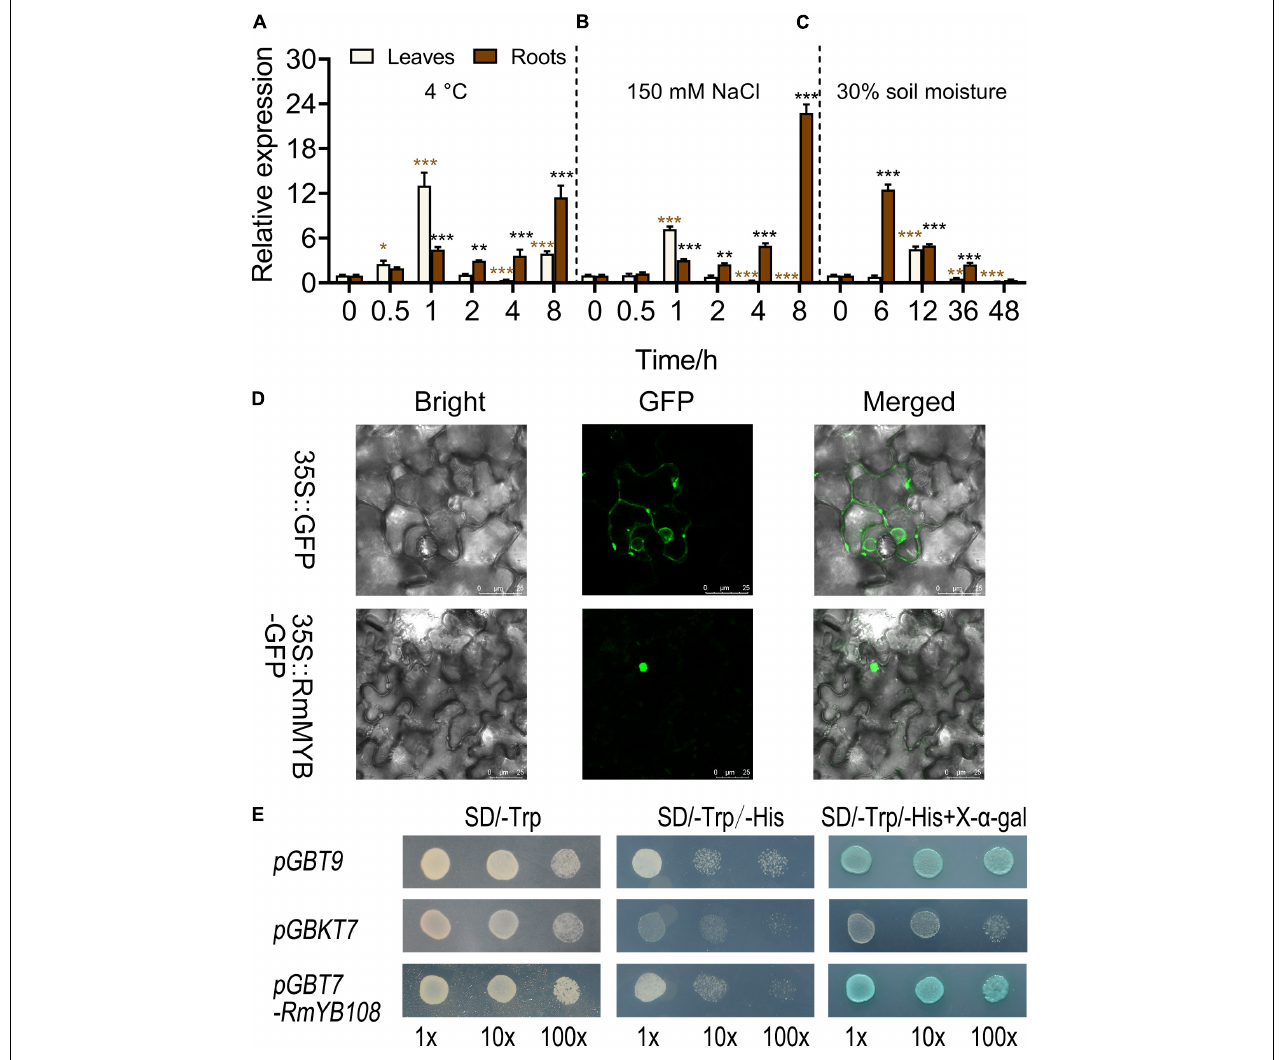
FIGURE 3 | Analysis of gene expression, localization, and transactivation assay of the RmMYB108 transcription factor. RmMYB108 expression patterns in R. multiflora leaves and roots responding abiotic stress under continuous 4 ◦ C (A) , 150 mM NaCl (B) , and drought (C) treatment. (D) The positive control 35S::GFP and 35S::RmMYB108 constructs were expressed in tobacco epidermal cells, showing the nuclear localization of RmMYB108 . (E) Transcriptional activation assay of RmMYB108 . Growth of yeast cells (strain AH109) transformed with pGBT9 vector (a positive control), pGBKT7 vector (a negative control), or pGBKT7- RmMYB108 vector on SD/-Trp or SD/-Trp/-His with or without X- α -gal. 10 × , 10 × , and 100 × represent yeasts were diluted with original concentration (OD600 = 0.4), 10–, 100-folds, respectively. * p < 0.05; ** p < 0.01; *** p < 0.001 in statistics.